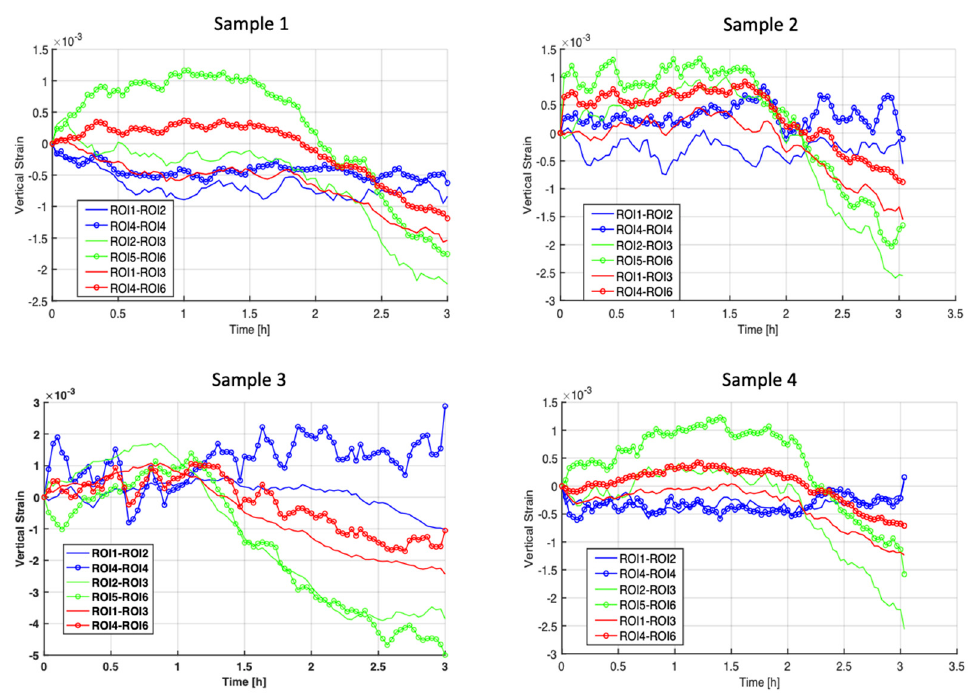
Figure 12. Measured vertical strains for the four hydrated samples.